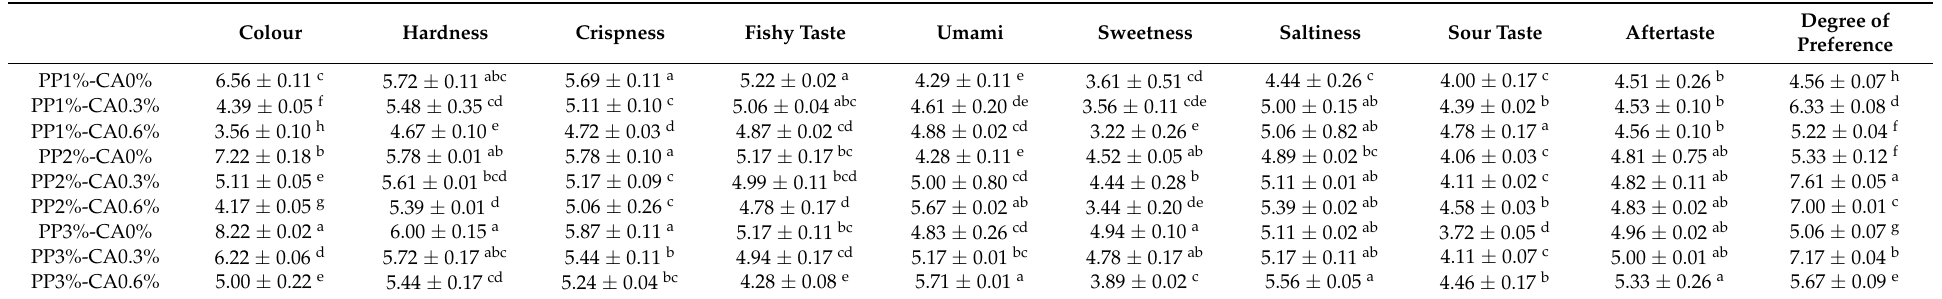
Table 4. Analysis table of sensory evaluation